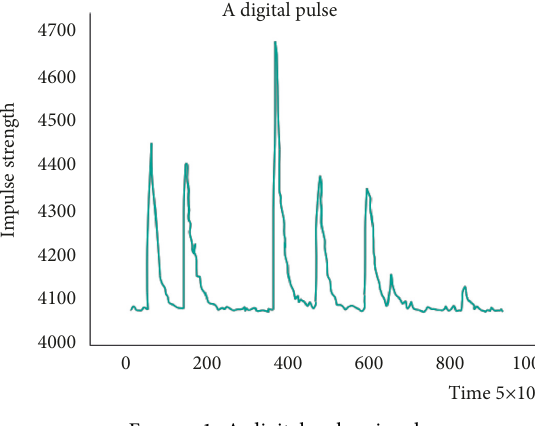
Figure 1: A digital pulse signal.